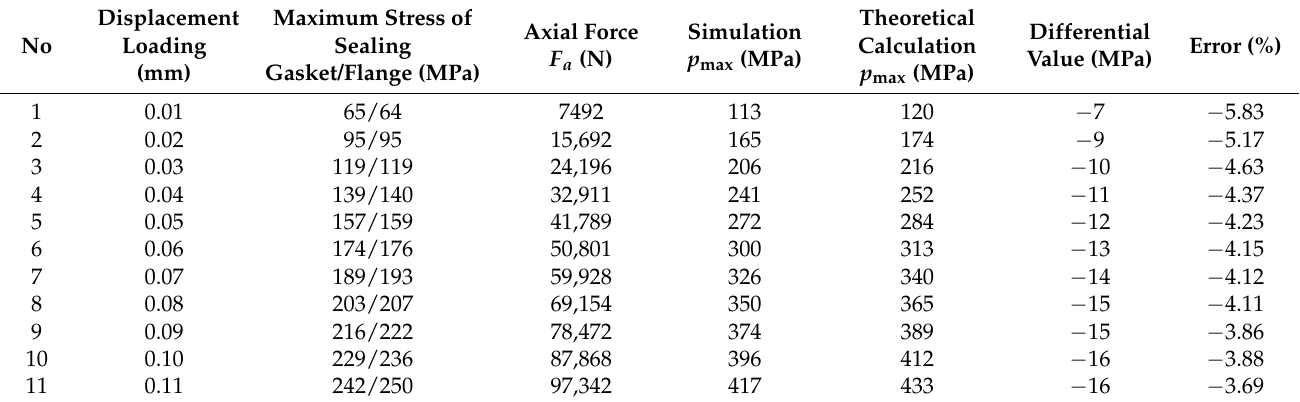
Table 2. Contact simulation and theoretical calculation data.